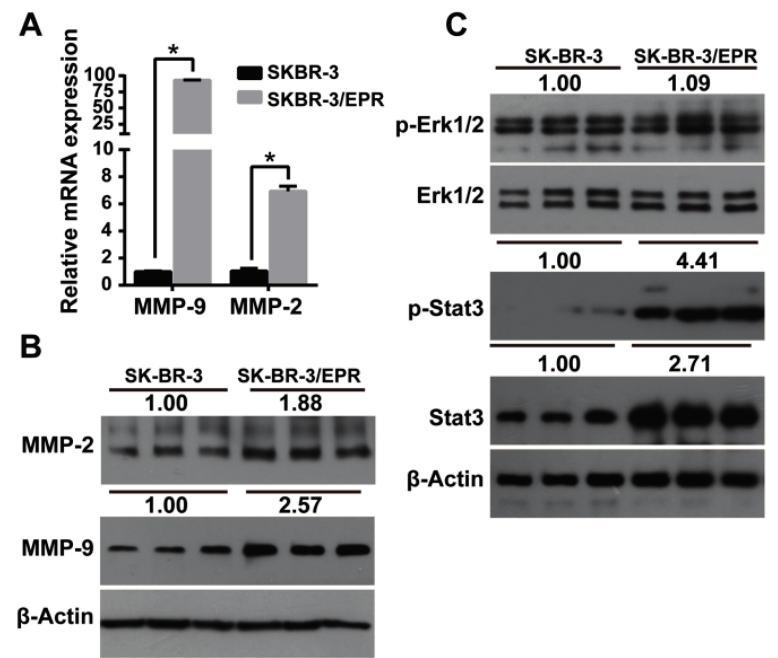
Figure 5. Expression of MMP-2 and -9 as well as phosphorylation of STAT3 was elevated in SK-BR-3/EPR cells. ( A ) Quantitative PCR analysis of expression of MMP-2 and -9 mRNA in SK-BR-3 and SK-BR-3/EPR cells. The experiments were performed using three replicates for each group and repeated three times; ( B ) Western blotting analysis of expression of MMP-2 and -9 protein in SK-BR-3 and SK-BR-3/EPR cells. The numbers above the blots show the relative values from the densitometric analysis. The levels of MMP-2 and -9 were normalized to β -actin, values are expressed as fold changes compared to SK-BR-3 cells; ( C ) Phosphorylation and activation of STAT3 was increased in MDR SK-BR-3/EPR cells. Western blotting analysis of expression of phosphorylation of Erk1/2 and STAT3 in SK-BR-3 and SK-BR-3/EPR cells. SK-BR-3 and SK-BR-3/EPR cells